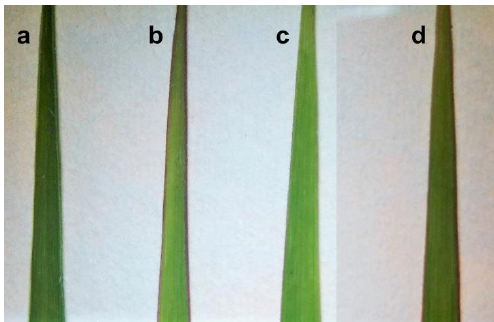
Figure 6. Photos of Mxg leaves used for microscopy sampled from variants ( a ) C, ( b ) H1, ( c ) H2 and ( d ) H2_R250 × 250.